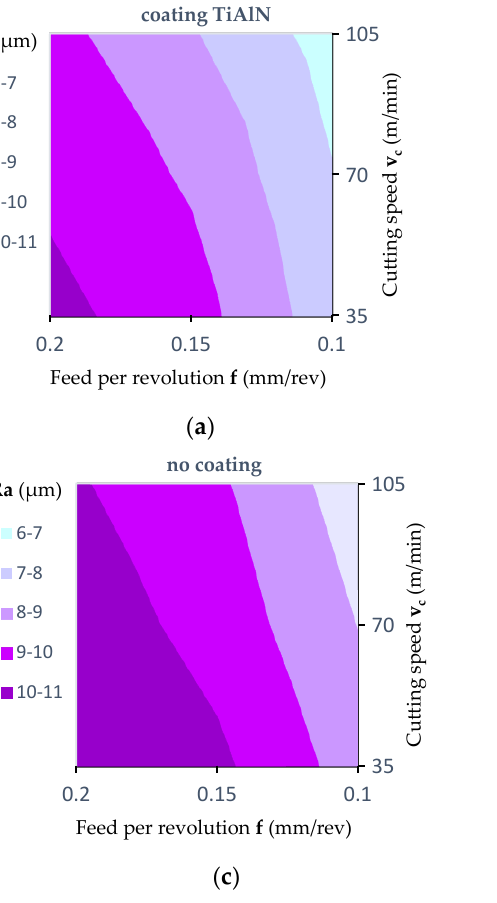
Figure 17. Influence of the feed value on the value of the surface roughness in the inner layer (contour